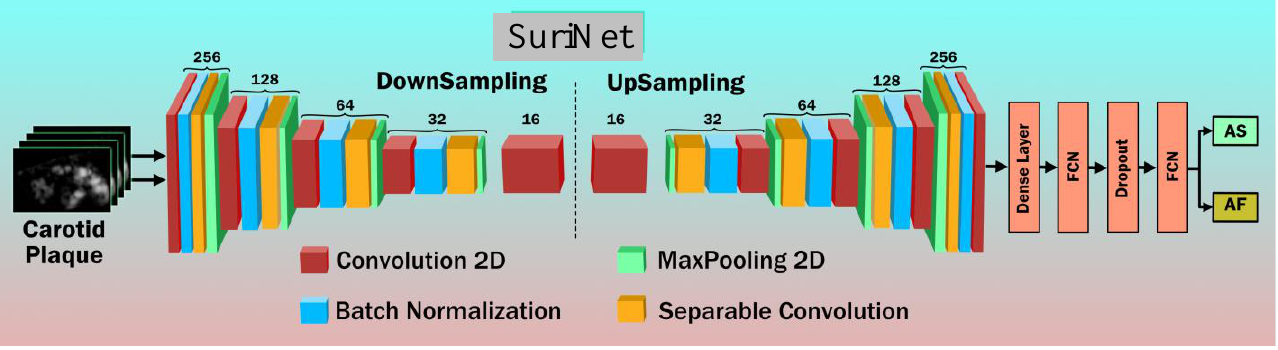
Figure 12. SuriNet architecture. Figure 12. SuriNet Table 1. SuriNet architecture parameters.